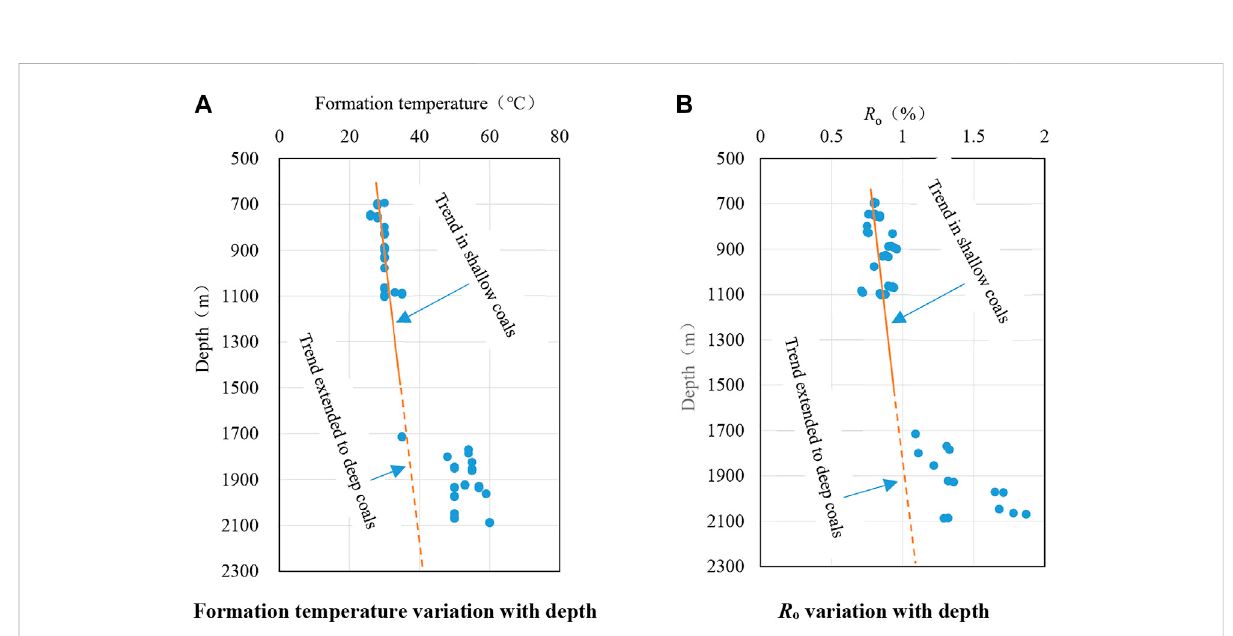
FIGURE 6 Diagram showing variations of formation temperature (A) and R o (B) , with depth in Linxing